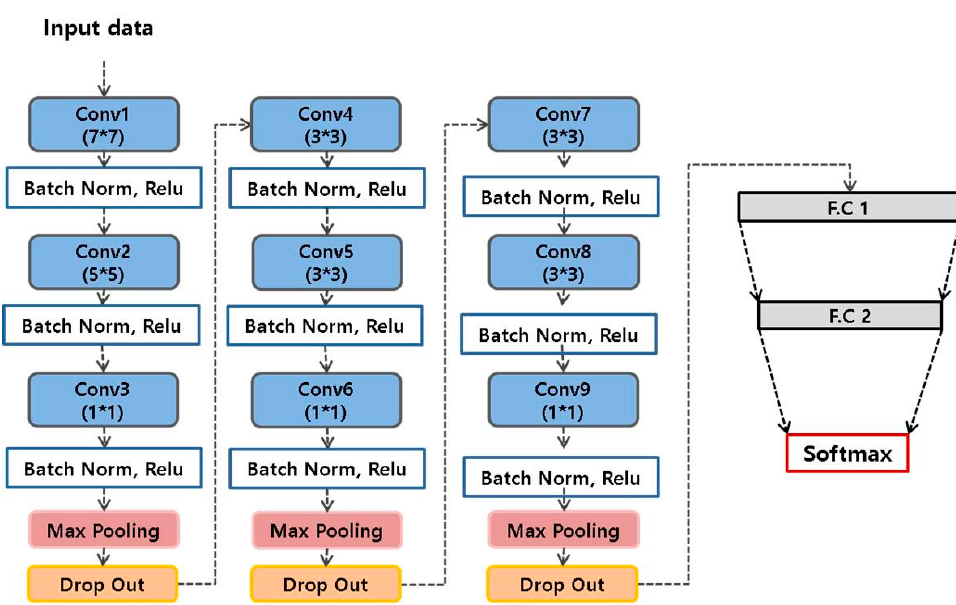
Figure 1. Architecture of the proposed convolutional neural network model.